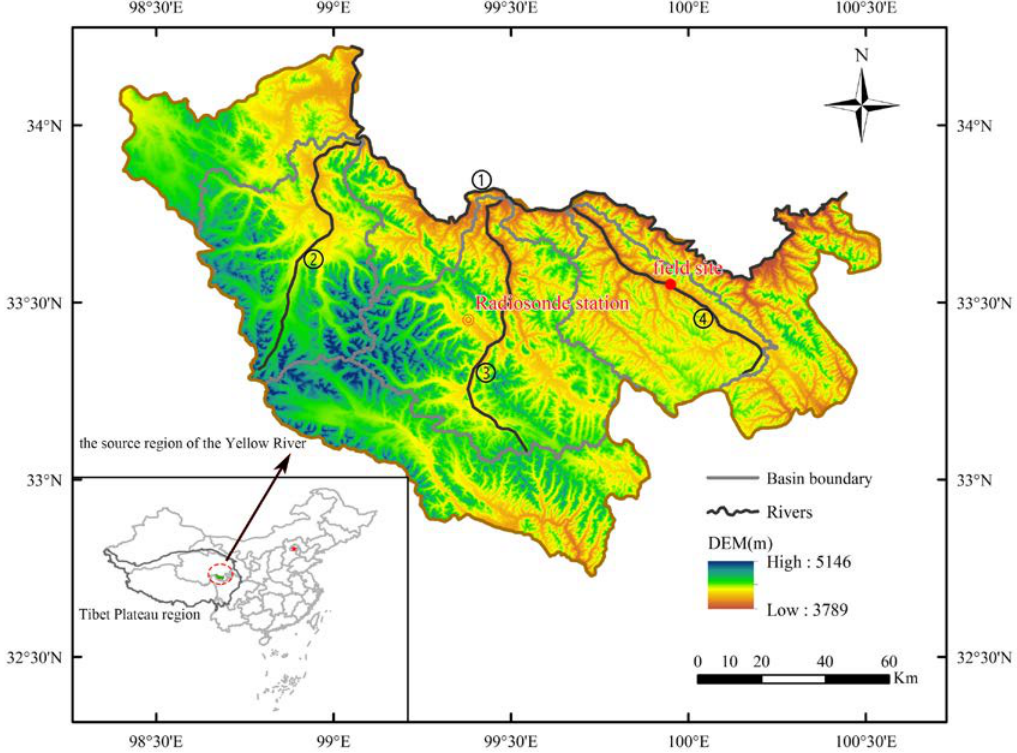
Figure 1. TP meteorological observation operation base: Yellow River mainstream (1) and corresponding tributaries of Kequ River (2), Darlag River (3), Jimai River (4). The black and white subgraph denotes the location of the source of the Yellow River in the TP. The color subgraph denotes the location of the operation site in the source region of the Yellow River.